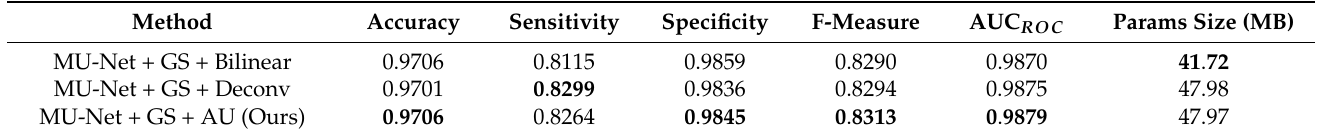
Table 2. Comparison of the proposed methods with other methods on the DRIVE dataset.